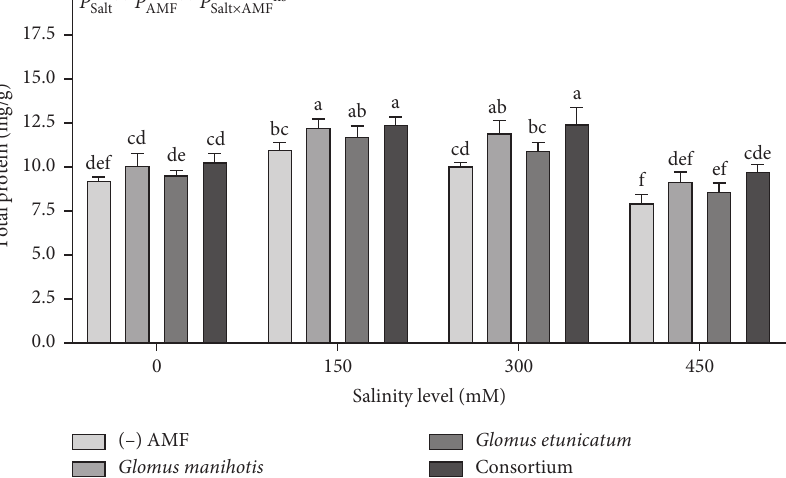
Figure 5: Effects of AMF inoculation on the total protein content of L. leucocephala leaves at different NaCl stress. AMF: arbuscular mycorrhizal fungi. ∗ : significant at 0.01 ≤ P ≤ 0 . 05; ∗∗ : significant at P ≤ 0 . 01. Bars that do not share a letter are significantly different at P ≤ 0 .